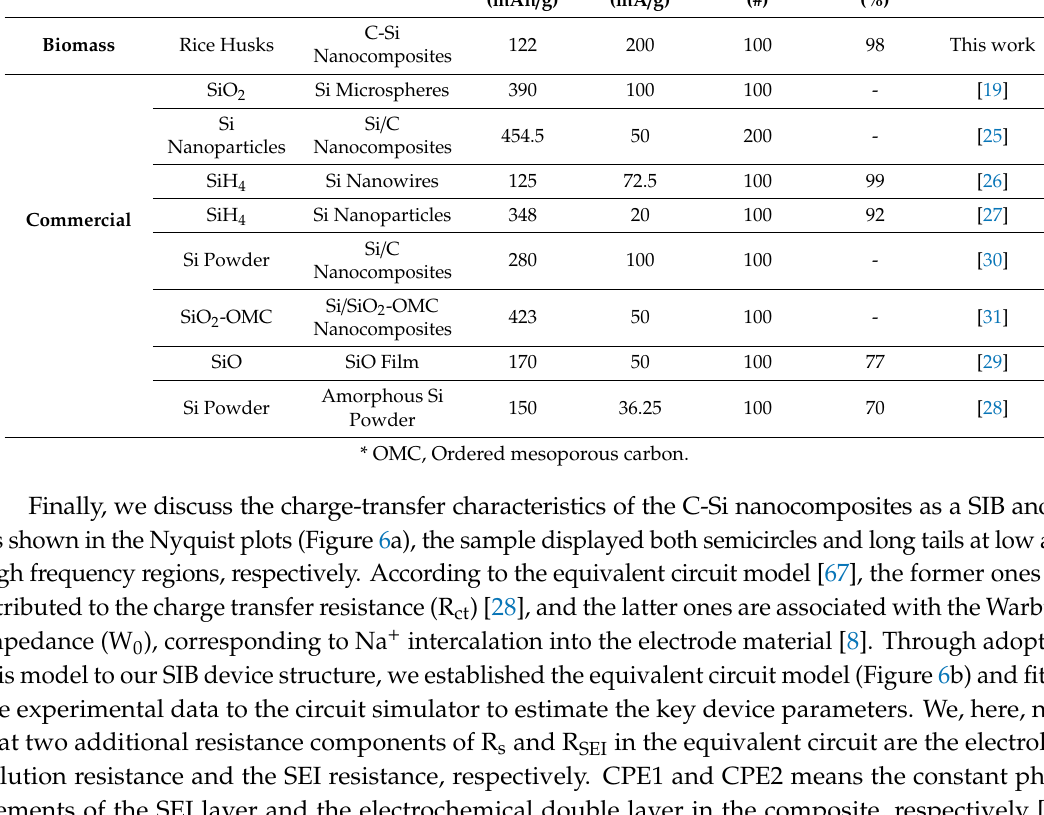
Anode Materials